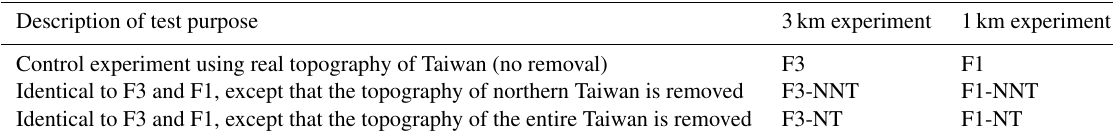
Table 3. Design and brief description of the CReSS experiments included in this study to test the effects of topography. The control experi- ments of F3 and F1 are the same as those given in Table